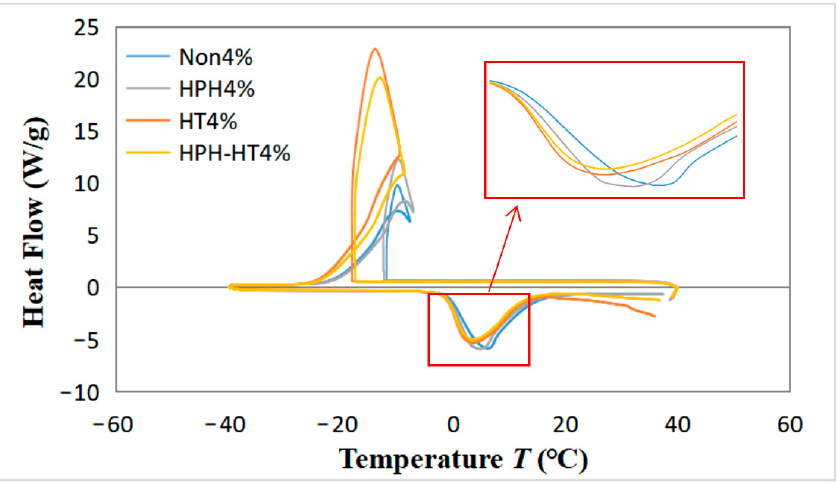
Figure 9. Di ff erential scanning calorimetry (DSC) curves of DCF dispersions in di ff erent treatment Figure 9. Differential scanning calorimetry (DSC) curves of DCF dispersions in different treatment with a concentration of 4% in one cooling and heating cycle. with a concentration of 4% in one cooling and heating